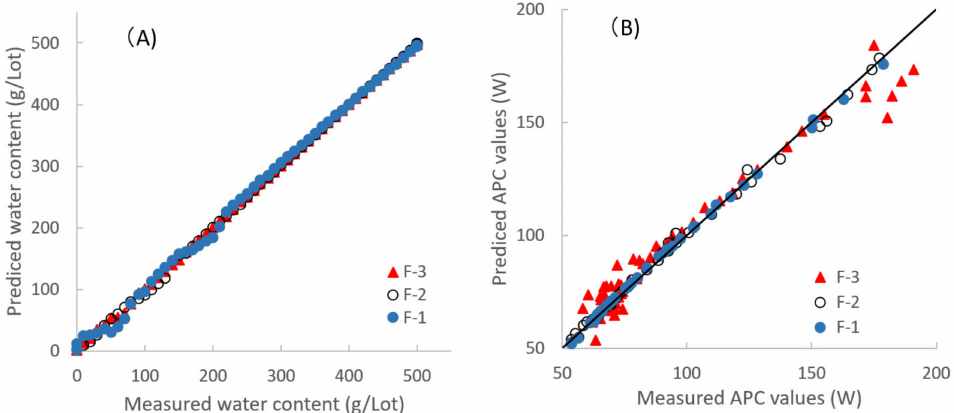
Figure 4. Relationships between measured values and predicted values of the amount of water added and the agitation power consumption during high-speed shear wet granulation processes. ( A ) The amount of water added (Wa); ( B ) the agitation power consumption